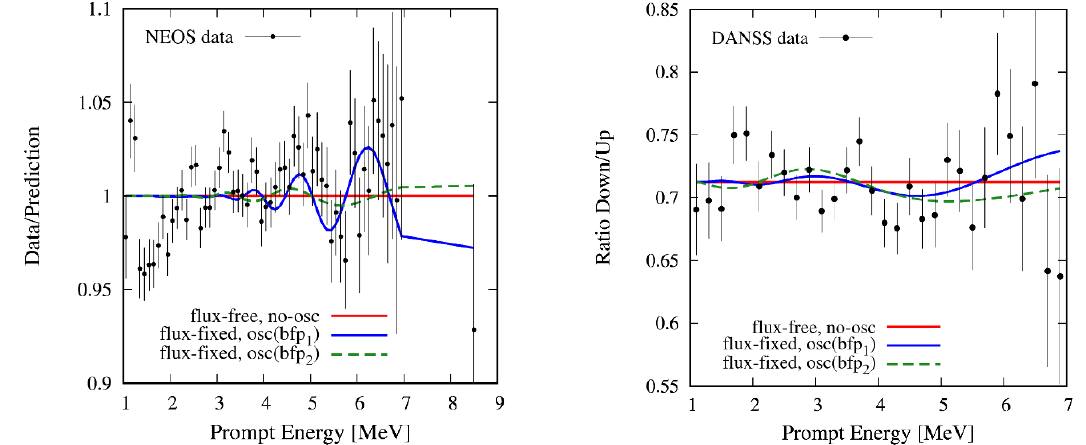
Figure 2 . Spectral data for NEOS (left) and DANSS (right) compared to the (cid:13)ux-free no-oscillation prediction (red) and the predictions in case of (cid:13)ux-(cid:12)xed + sterile neutrino oscillations, where bfp 1 (blue-solid curve) and bfp 2 (green-dashed curve) correspond to the best (cid:12)t points from combined { ) reactor data and global ( (cid:23) e disappearance data, respectively, see table 3. Error bars correspond to statistical errors only. Details of the observables and predictions for the two experiments can be found in the appendix. The large distortions of the NEOS data below 2 MeV are within the systematic error band (not shown, see